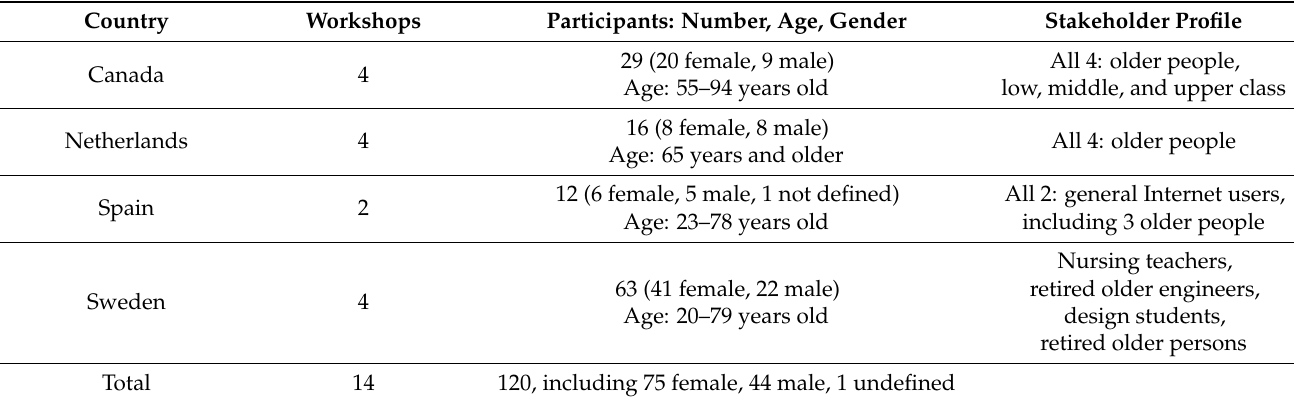
Table 1. Participants distributed over partner country, number of design workshops, number of participants and their gender and age, and profile of